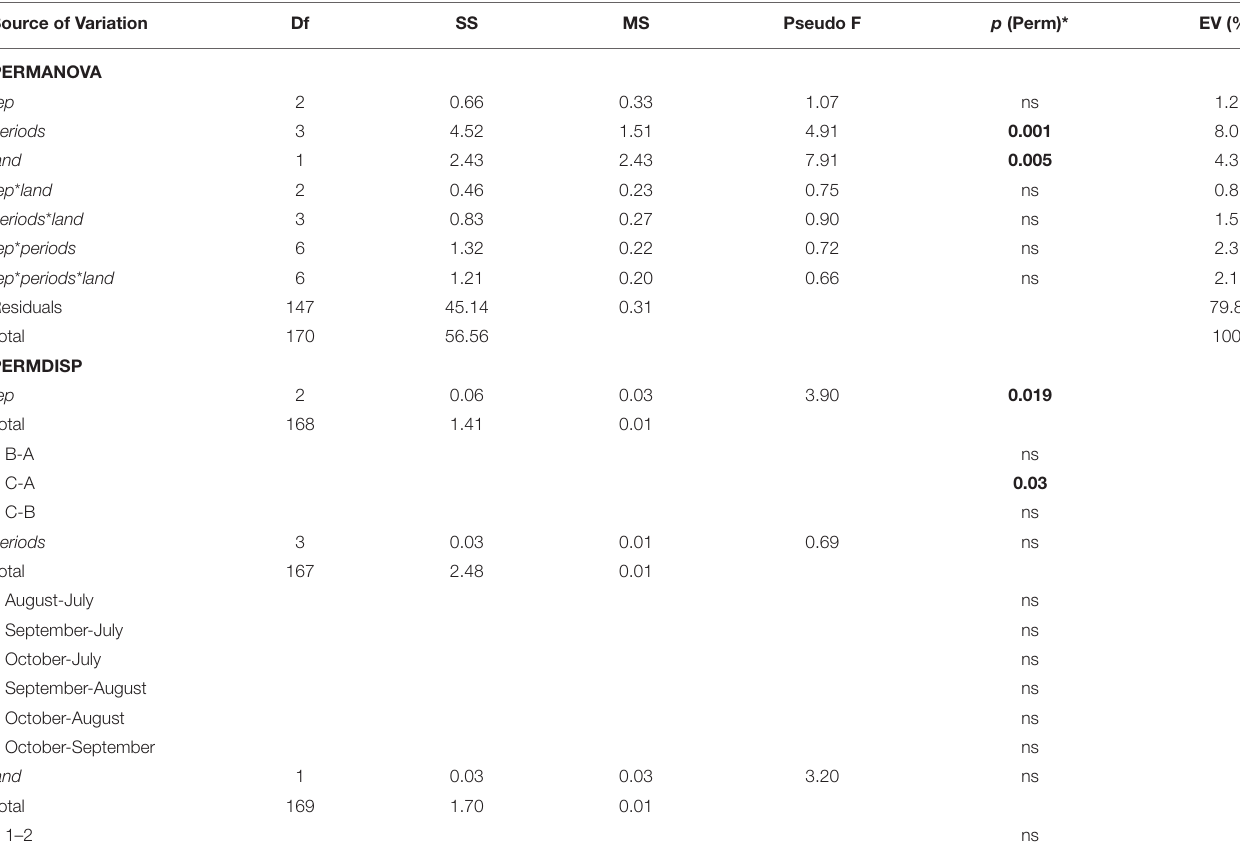
TABLE 3 | PERMANOVA and PERMDISP analysis of the effect of between groups of farthest sampling sites (3 “rep” for each city), collecting period (4 “periods” - from July to October), and landscape (cluster group 1 and 2 “land”) on community composition of Culicidae collected in central-south Illinois in 2016–2017. Source of Variation Df SS MS Pseudo F p (Perm)* EV (%)